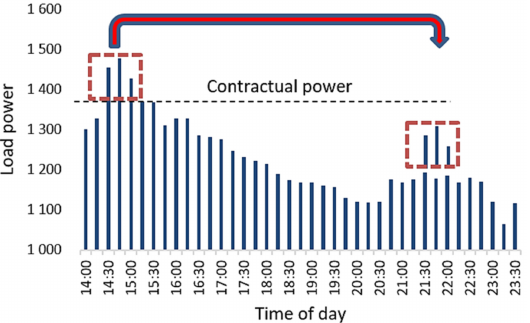
Figure 1. Reduction of the power load peak by a BESS in order to reduce contractual power.